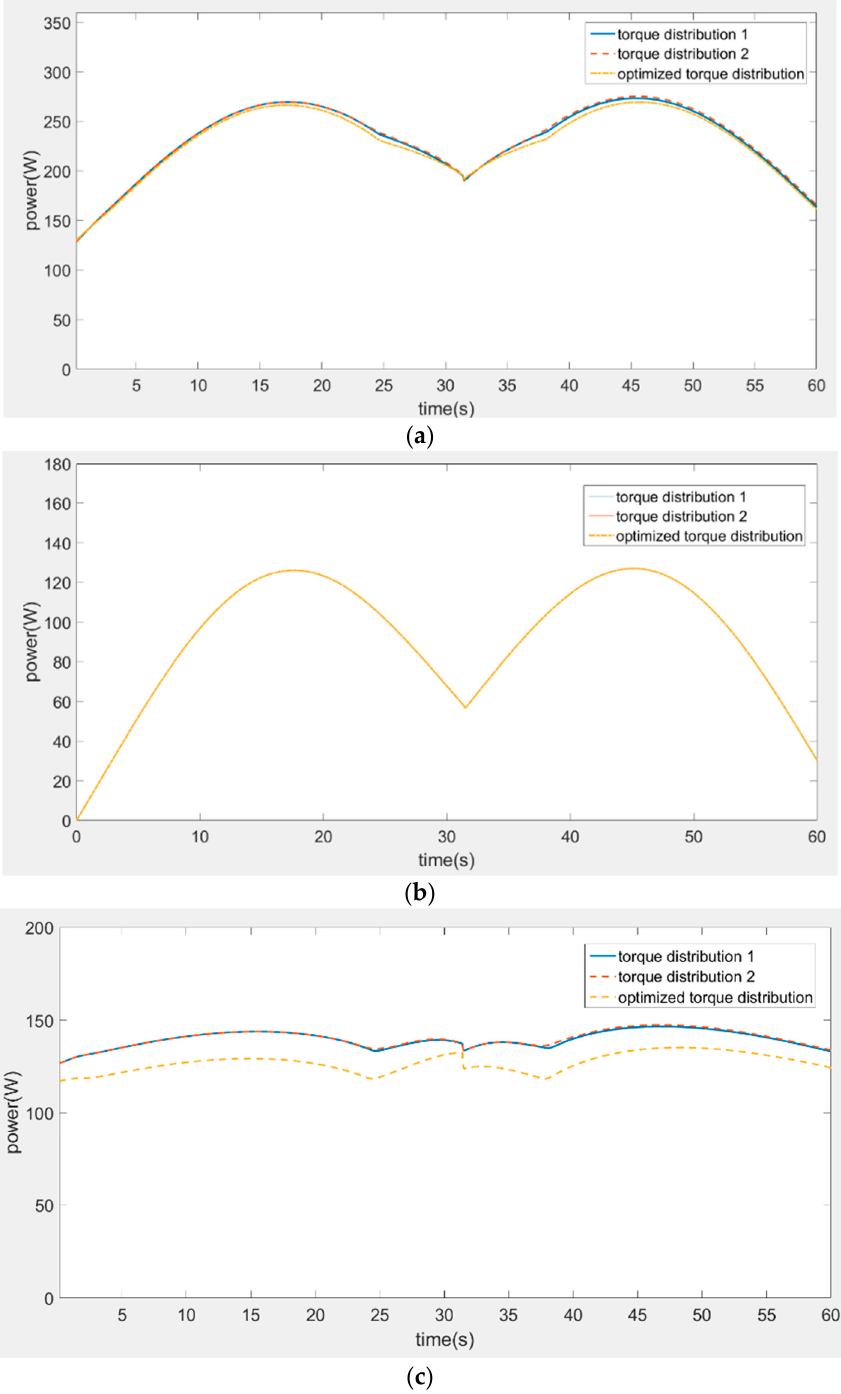
Figure 11. Power consumption of the OMR following the trajectory: ( a ) total power consumption; ( b ) output power consumption; ( c ) electrical power loss. Table 2. Simulation results of total energy consumption for the curvilinear trajectory.